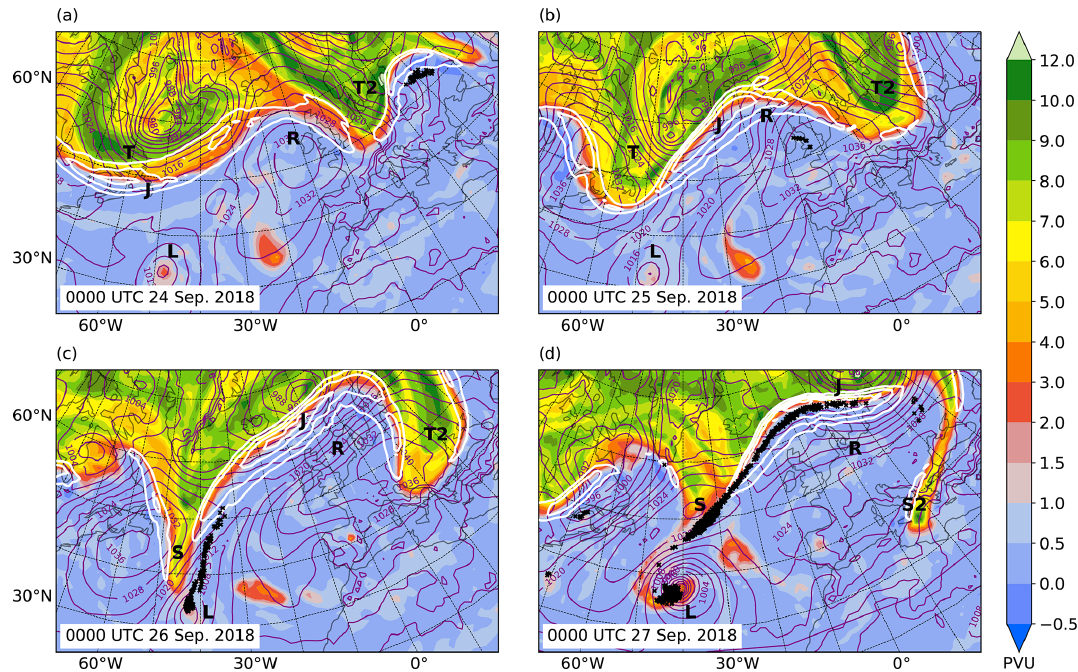
Figure 1. Synoptic situation over the Euro-Atlantic sector before the formation of Medicane Zorbas. PV (shaded, in PVU) and wind speed (white contours; 50, 60, 70, 80ms − 1 ) at 325K; intersection points of warm conveyor belts (ascent rate of more than 600hPa in 48h) with the 325K isentrope (black crosses); and sea level pressure (purple contours, every 4hPa) at (a) 00:00UTC 24 September 2018, (b) 00:00UTC 25 September 2018, (c) 00:00UTC 26 September 2018, and (d) 00:00UTC 27 September 2018. Labels mark relevant flow features (for details see